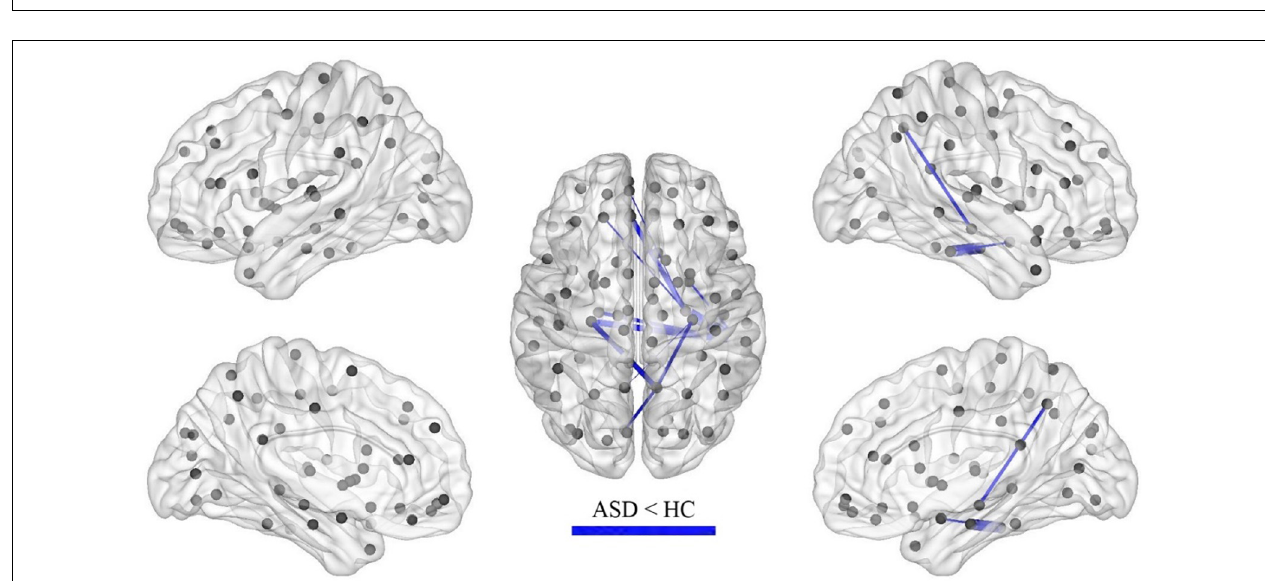
FIGURE 4 | Subnetworks with decreased FC in ASD ( p =